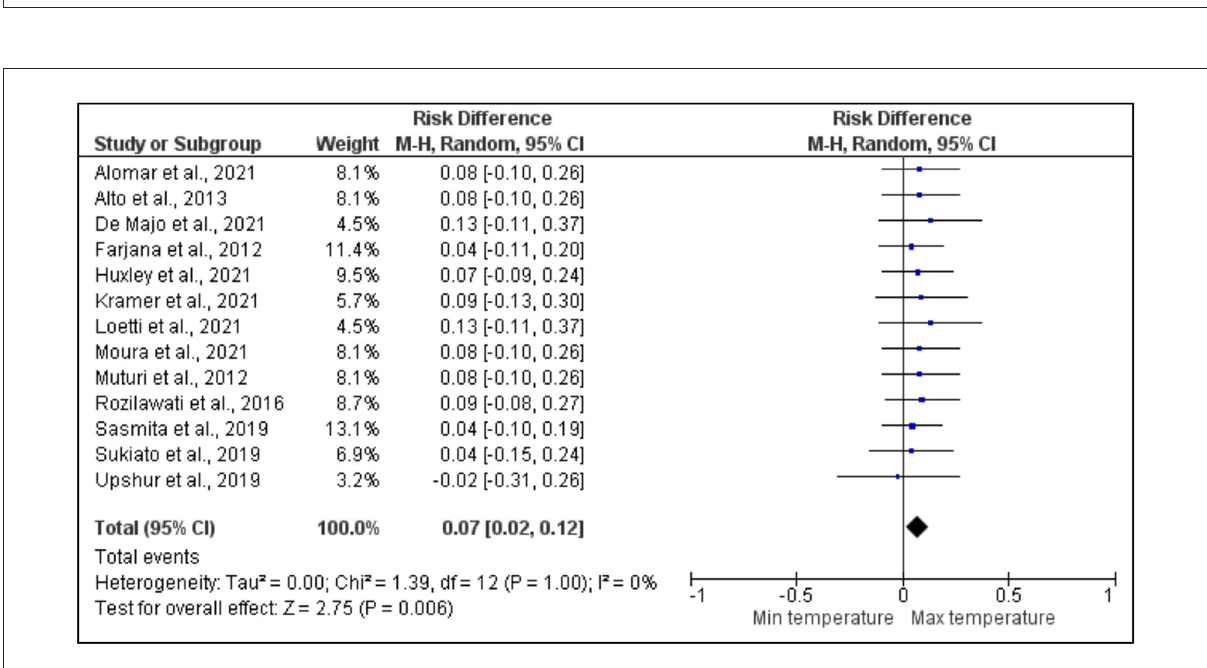
FIGURE7 Forest plot of comparison of the effect of minimum temperature vs. maximum temperature on the wing morphology of dengue